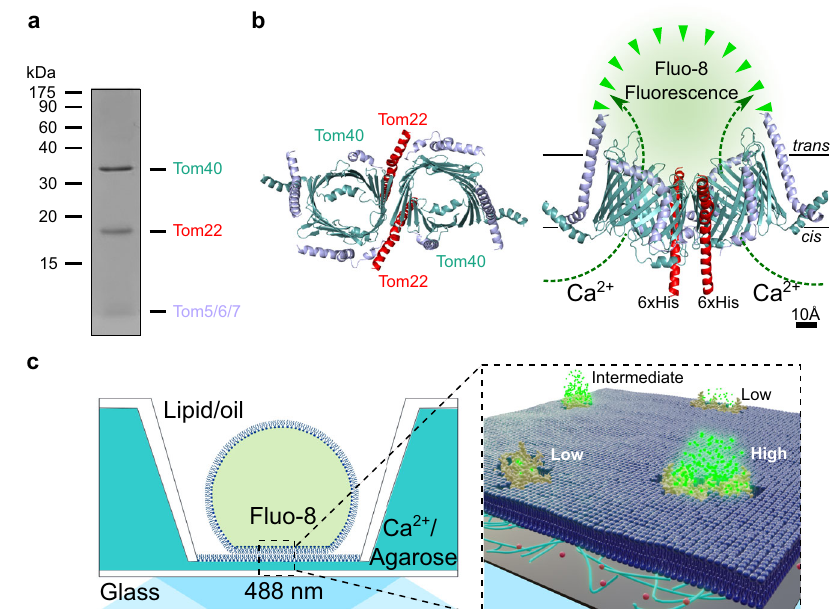
Fig. 1 Scheme for tracking single TOM-CC molecules and imaging their ion channel activity. a TOM-CC was isolated from mitochondria of a Neurospora strain carrying a Tom22 with a hexahistidinyl tag (6xHis). Analysis of puri fi ed protein by SDS-polyacrylamide gel electrophoresis (SDS-PAGE) followed by Coomassie Blue staining revealed all known subunits of the core complex, Tom40, Tom22, Tom7, Tom6 and Tom5. The small subunits Tom7, Tom6 and Tom5 are not separated by SDS-PAGE. b Atomic model based on the cryoEM map of N. crassa TOM core complex (EMDB, EMD-3761 6 ). The ionic pathway through the two aqueous β -barrel Tom40 pores is used to optically study the open-closed channel activity of individual TOM-CCs. Left, cytosolic view; right, side view; cis , mitochondria intermembrane space; trans , cytosol. Tom7, Tom6 and Tom5 are not labeled for clarity. c Single-molecule tracking and channel activity sensing of TOM-CC in DIB membranes using electrode-free optical single-channel recording. Left: Membranes are created through contact of lipid monolayer-coated aqueous droplets in a lipid/oil phase and a lipid monolayer on top of an agarose hydrogel. The cis side of the membrane contained Ca 2 + -ions (0.66 M), while having at the trans side a Ca 2 + -sensitive fl uorescent dye (Fluo-8) and KCl (1.32 M) to balance the membrane osmotic pressure. The high Ca 2 + content is necessary to induce high calcium fl ux through the TOM-CC pores and to provide reliable optical signals. Right: Ca 2 + -ion fl ux through individual TOM-CCs from cis to trans is driven by a Ca 2 + concentration gradient, established around the two Tom40 pores, and measured by monitoring Fluo-8 emission in close proximity to the membrane using TIRF microscopy. Fluorescence signals reveal the local position of individual TOM-CCs, which is used to determine their mode of lateral diffusion in the membrane. The level of the fl uorescence (high, intermediate and low intensity) correlates with corresponding permeability states of a TOM-CC molecule. A 100× TIRF objective is used both for illumination and imaging. Green dots, fl uorescent Fluo-8; red dots, Ca 2 +